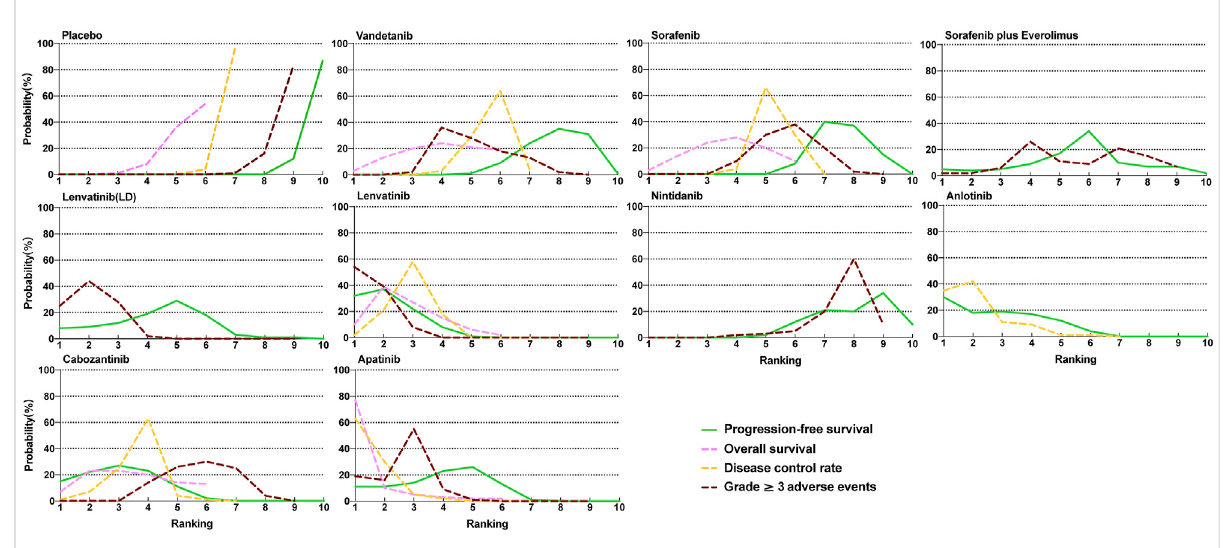
FIGURE 4 Pro fi les indicate the probability of each comparable treatment being ranked from fi rst to last on overall survival, progression-free survival, disease control rate, and grade 3 or higher adverse